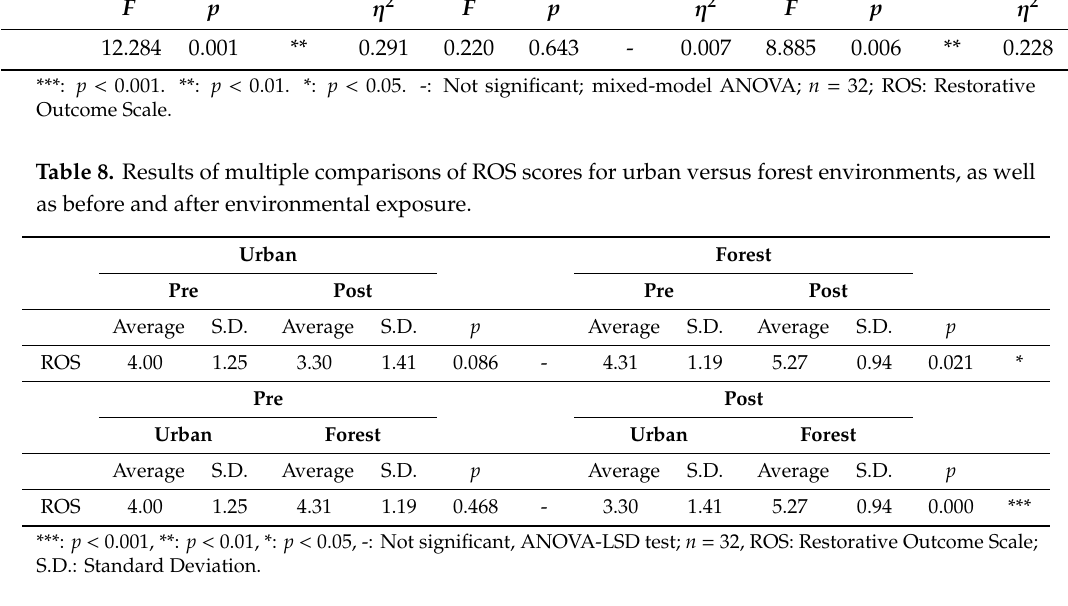
Table 7. Results for mixed-model ANOVAs investigating Restorative Outcome Scale (ROS) scores. Main E ff ect Interaction Conditions: Urban vs. Forest Time: Pre vs. Post Conditions × Time ROS F p η 2 F p η 2 F p η 2 12.284 0.001 0.291 0.220